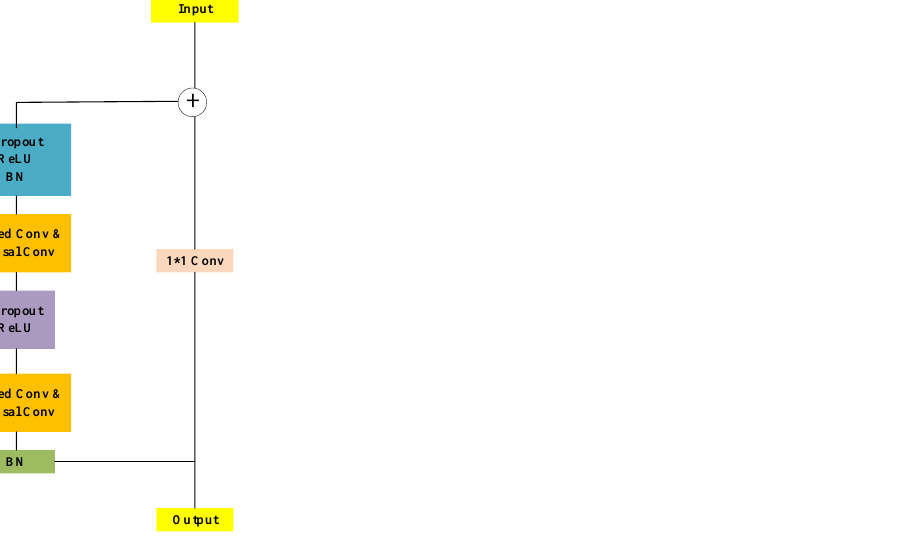
Figure 7. The structure of the Temporal Convolutional Network. Dilated casual convolution, weight normalization, dropout, and the optional 1 × 1 Convolution are needed to complete the residual block.